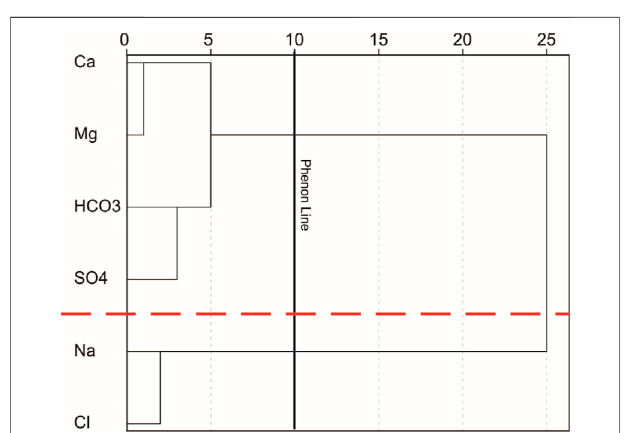
FIGURE 5 | Dendrogram of HCA results.